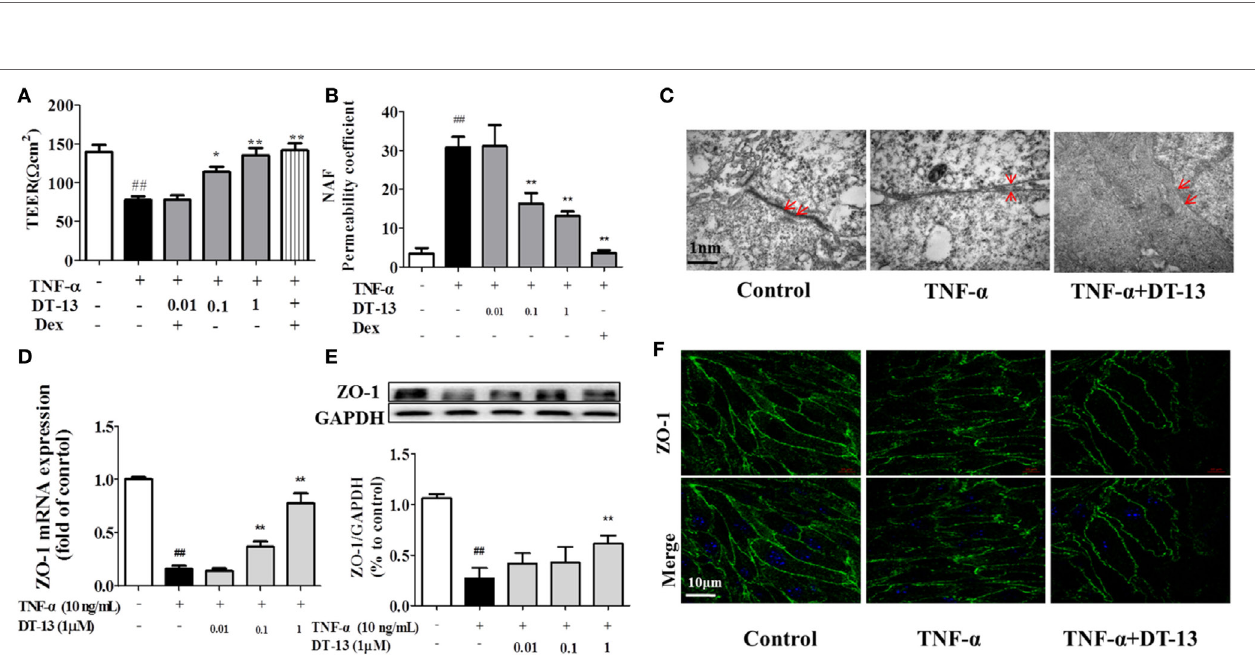
FigUre 1 | DT-13 prevented TNF- α -induced vascular hyperpermeability and ZO-1 disassembly in vivo . (a) Photographs of ears after treatment with mustard oil (30 min). (B) OD measurements of extravasated Evans blue in mouse ears 30 min after topical application of mustard oil. (c) The expression of ZO-1 in the mouse aorta was measured by Western blotting. (D) Immunostaining of ZO-1 in the mouse aorta endothelium. Bar = 20 μ m. The ZO-1 in green and the DAPI in blue. The data represent the mean ± SD from three experiments. ## P < 0.01 vs. the control group; ** P < 0.01 vs. the TNF- α group.